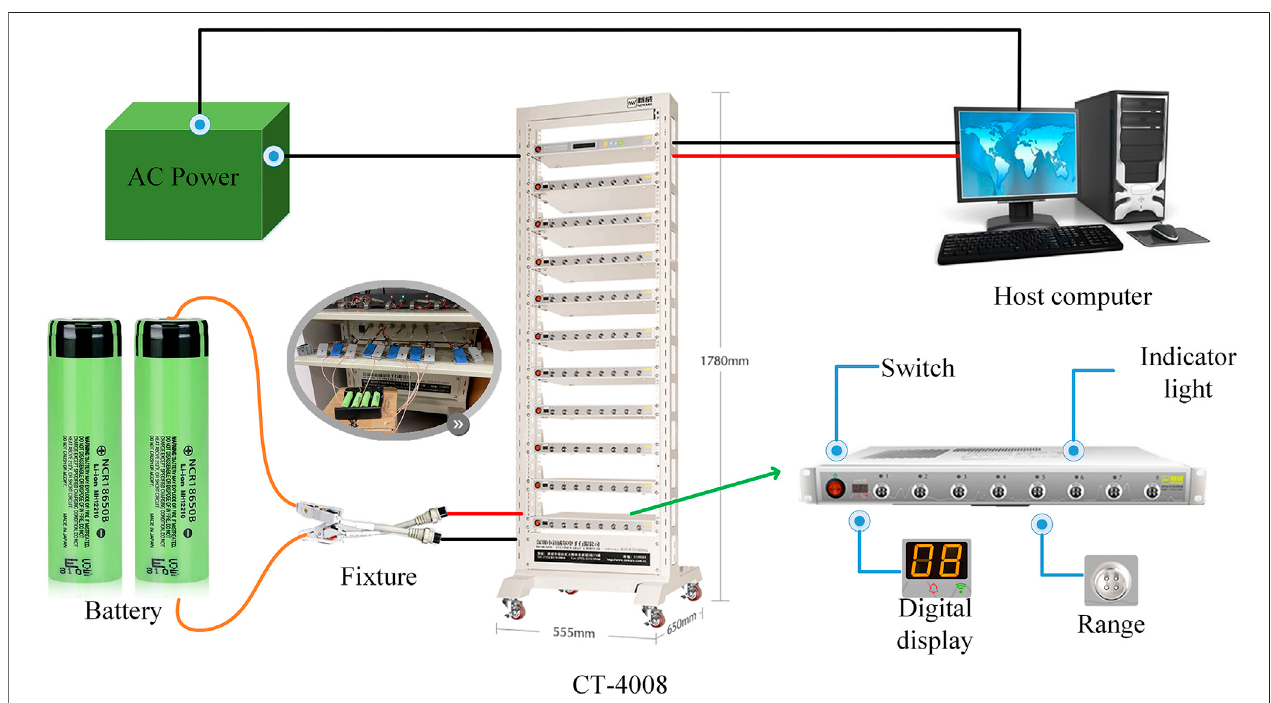
FIGURE 3 | The con fi guration of the test bench.